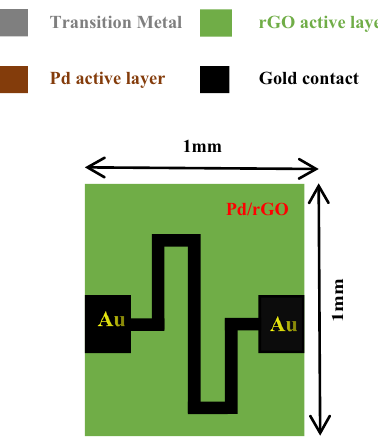
Figure 2. Top view of chemical gas sensor with Pd/rGO active